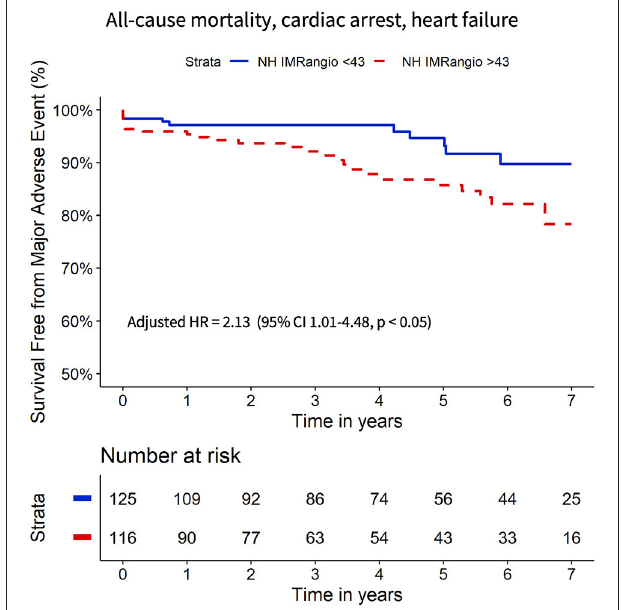
FIGURE 5 | Kaplan Meier curves of freedom from all-cause mortality, resuscitated cardiac arrest, new heart failure diagnosis with high vs. low NH IMR angio adjusted for age, ischaemic time, LVEF%. HR, hazard ratio; CI, confidence interval; LVEF, left ventricle ejection fraction; NH IMR angio , non-hyperaemic IMR angio